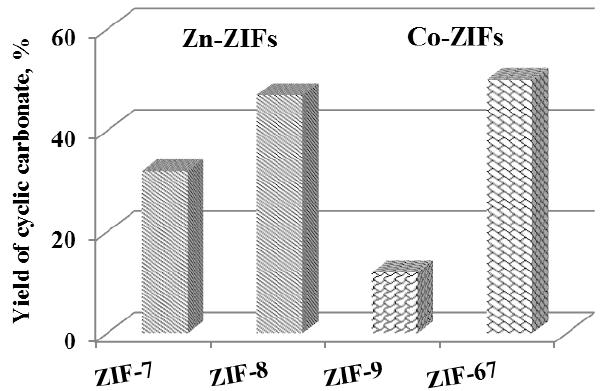
Figure 4. Catalytic properties of ZIFs in the synthesis of cyclic carbonate from CO 2 and epichlorohydrin (experimental conditions: 18 mmol of EPH, 0.1 g of catalyst, 0.6 MPa of CO 2 , 353 K, 6 h). The selectivity for cyclic carbonate in the presence of Co/Zn–ZIF (90–98%) was higher Kuruppathparambil et al. [74] investigated the effect of Co on the activity of ZIFs in than that in the presence of ZIF-8 (33.4%). Furthermore, other research groups reported